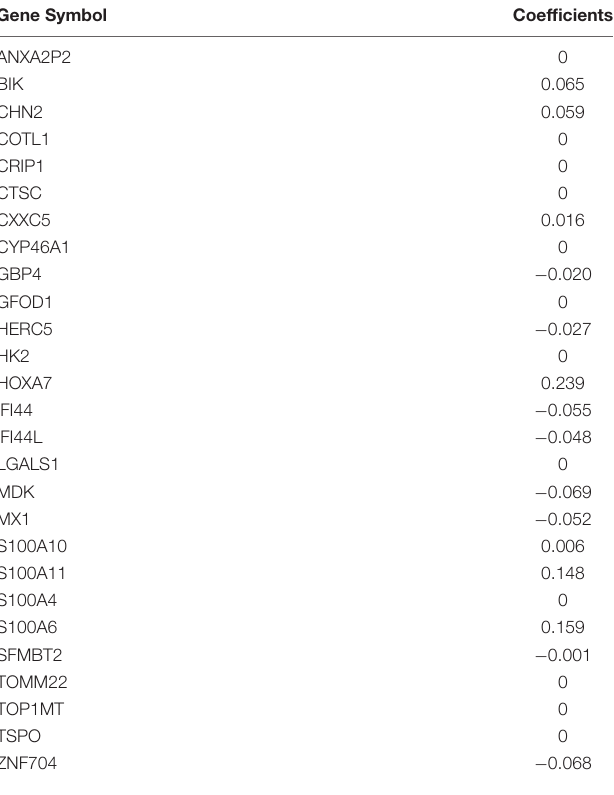
TABLE 4 | The result of LASSO regression in training